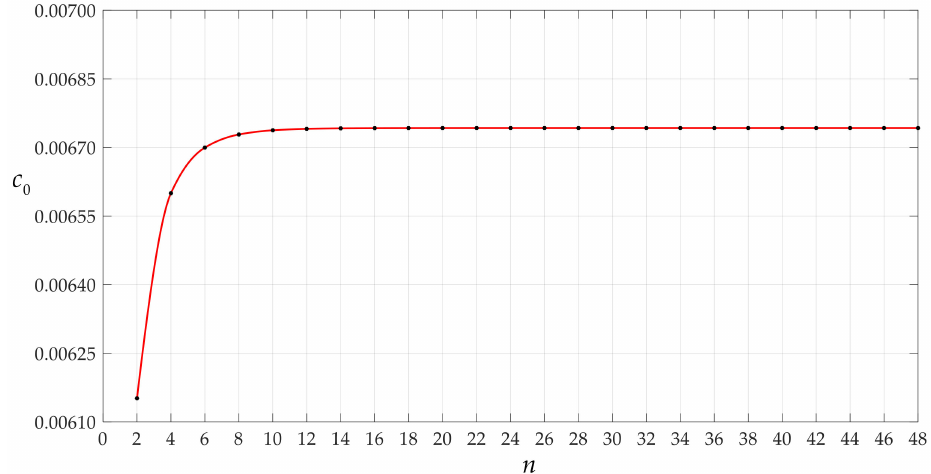
Figure 7. Variations of c 0 with n when q takes 0.00004 MPa.